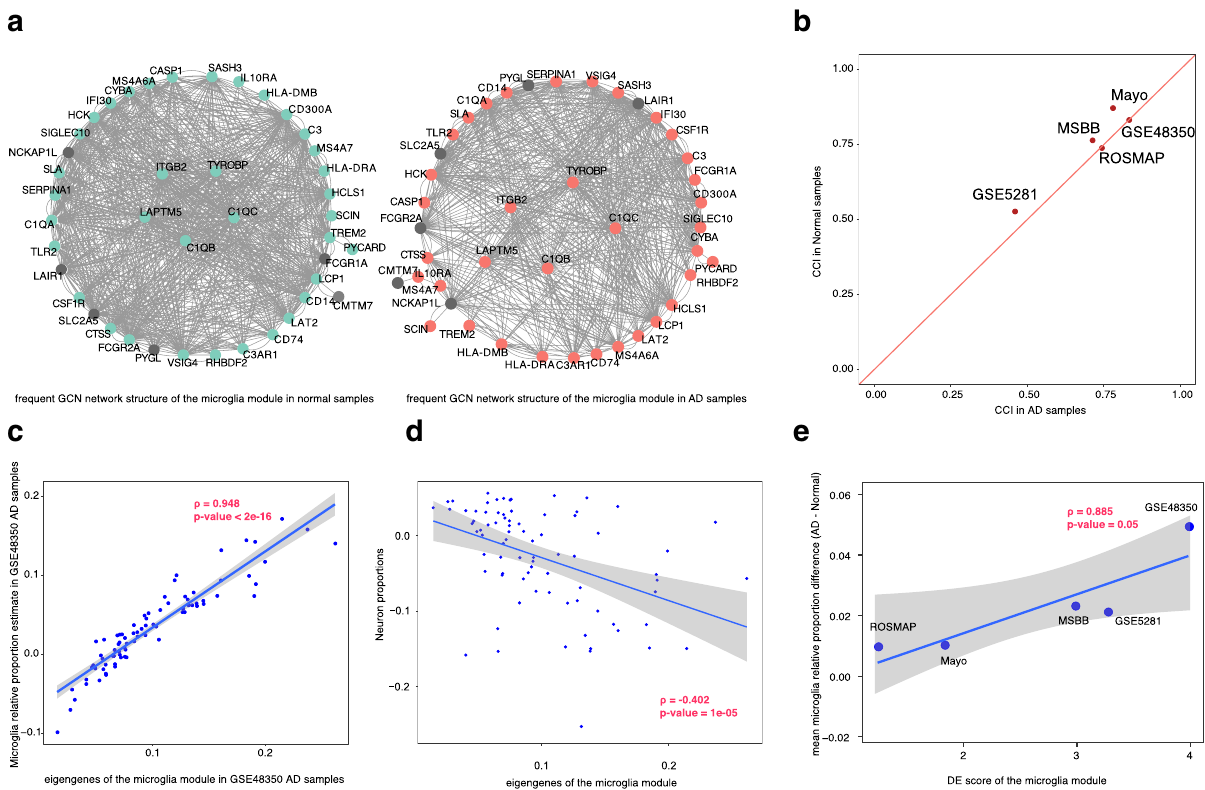
Figure 3. The high differential expression in microglia modules with low differential co-expression was largely due to changes in cell-type proportions. ( a ) Network visualization of the microglia module in the AD samples and controls (for legibility, only gene links that appeared in at least in four of the five datasets are shown). The genes with blue color in control networks and red color in AD networks were had higher expression in the AD samples than in the control samples in at least two of the five datasets. ( b ) Centered concordance index (CCI) values of the microglia module in AD samples vs. controls in each of the five datasets. ( c ) The Pearson correlation between microglia module eigengenes and the estimated microglia relative proportions in the GSE48350 dataset. ( d ) The Pearson correlation between microglia module eigengenes and the estimated neuron relative proportions. This is shown as a poor correlation to compare with panel c. ( e ) The differential expression scores of the microglia module with the mean microglia relative proportion changes between the AD samples and controls across the five datasets. The gray area indicates the region defined by 95% confidence